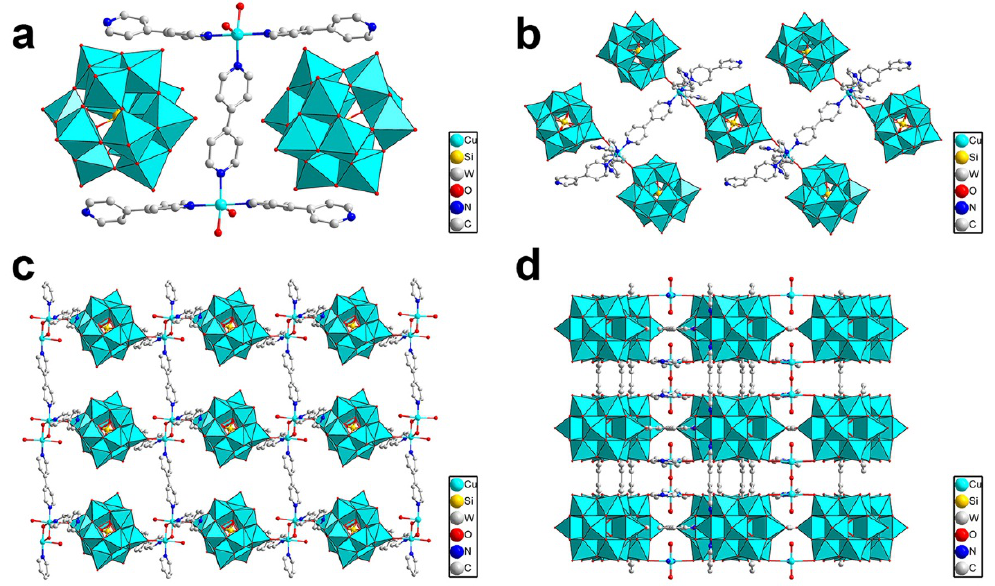
Figure 6. ( a – d ) Polyhedral and ball-and-stick representation for the compounds 1 – 4 based on [SiW 12 O 40 ] 4 −